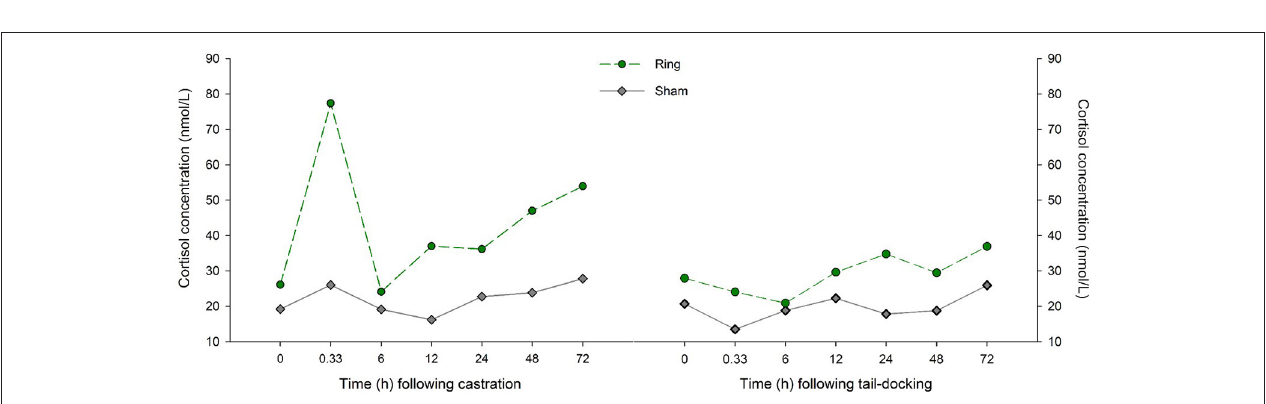
FIGURE 3 | Raw data of the mean cortisol concentrations (nmol/L) for lambs in the Sham ( n = 16) and Ring ( n = 16) treatment groups following castration and tail-docking.